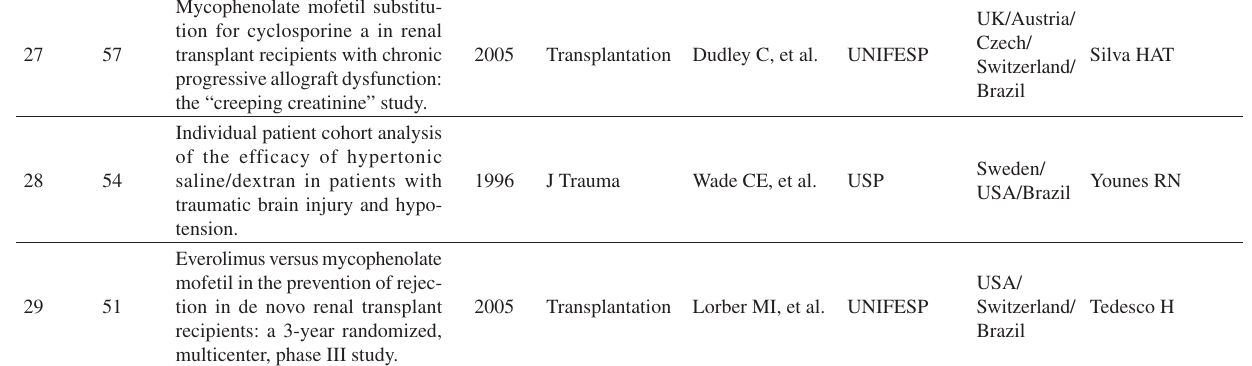
Results of a prospective trial on elective modified radical classi- cal versus supraomohyoid neck dissection in the management of oral squamous carcinoma. Brazilian Head and Neck Cancer Study Group.